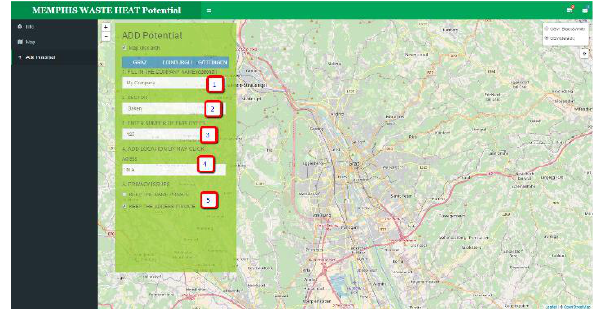
Figure 4. Waste Heat Explorer - Add Potential © AIT 2018